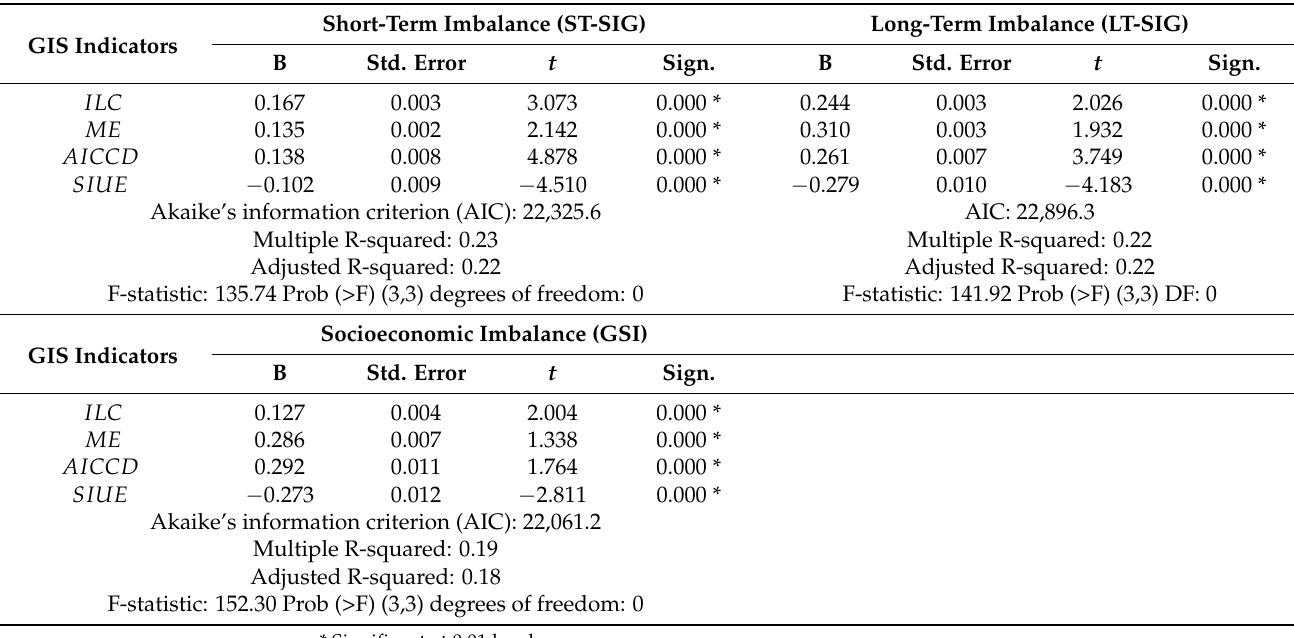
Table 6. Detailed multiple regression models (OLS) for LISA analysis of the different levels of spatial correlation between port area configuration and coastal impact indicators in the study